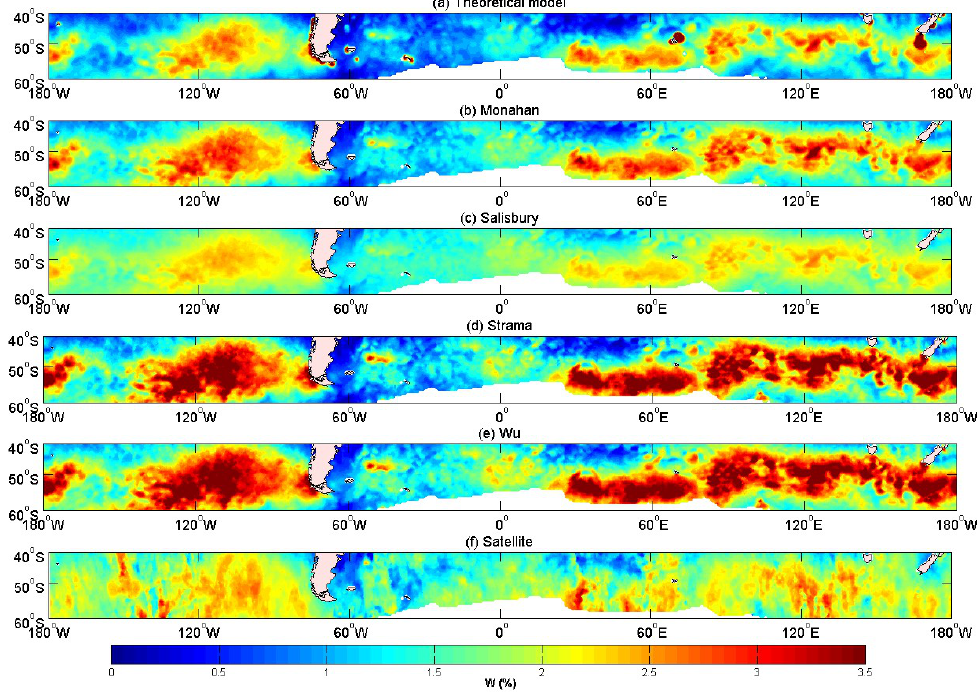
Figure 9. Distributions of the whitecap coverage from different models over 40° S–60° S and 180° E– 180° W. (From top to bottom): ( a ) Statistical theoretical model of the whitecap coverage ( 𝐶 (cid:3032)(cid:3041) = 0.1777, n = −1.713, 𝜃 = 11, 𝐹 (cid:3021) = 0.75, ρ = 0.53), ( b ) Monahan’s empirical relationship [58], ( c ) Salisbury’s fitting formula [20], ( d ) Strama’s empirical relationship [40], ( e ) Wu’s empirical relationship [37], and ( f ) satellite-derived result [20]. A unified scale colorbar with values from 0 to 3.5% is